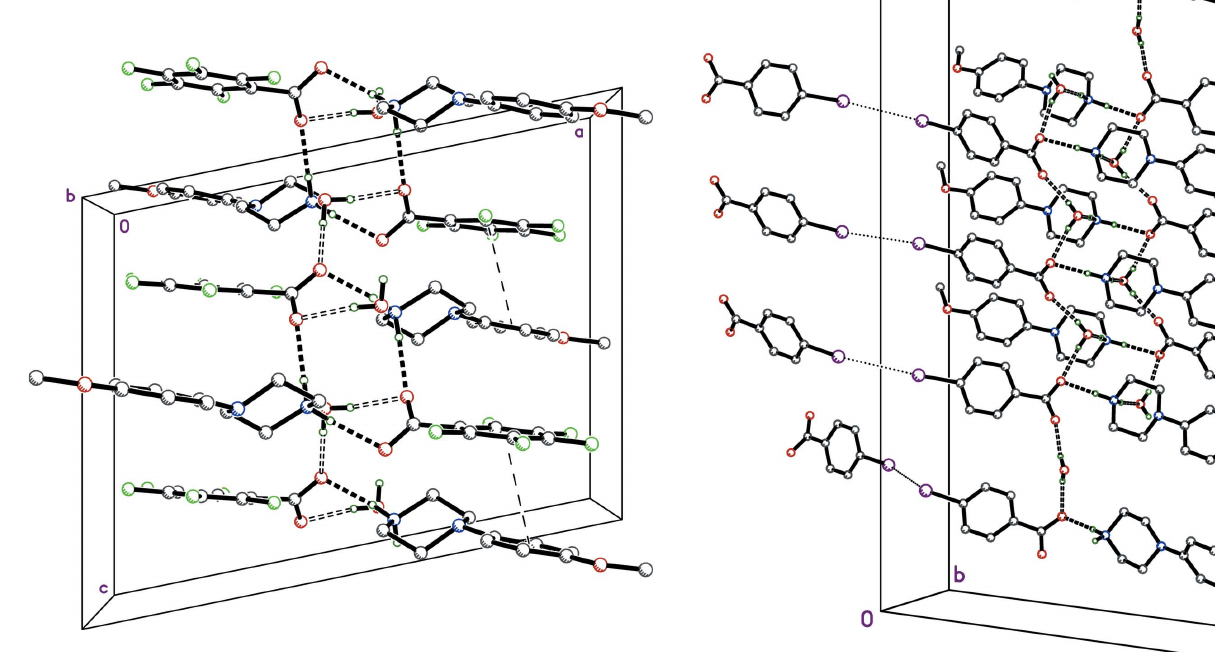
Figure 8 A partial packing plot of III viewed approximately down the b -axis showing a slice through the N—H (cid:2)(cid:2)(cid:2) O (solid dashed lines) and O— H (cid:2)(cid:2)(cid:2) O (open dashed lines) hydrogen-bonded double layers, which stack along the b -axis direction via I (cid:2)(cid:2)(cid:2) I close contacts (dotted lines). Hydrogen atoms not involved in hydrogen bonds are